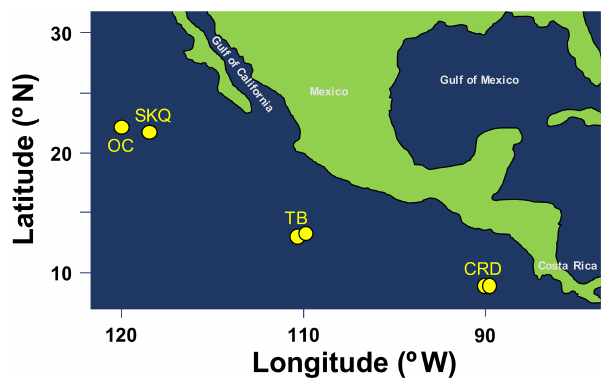
Figure 1. Map showing station